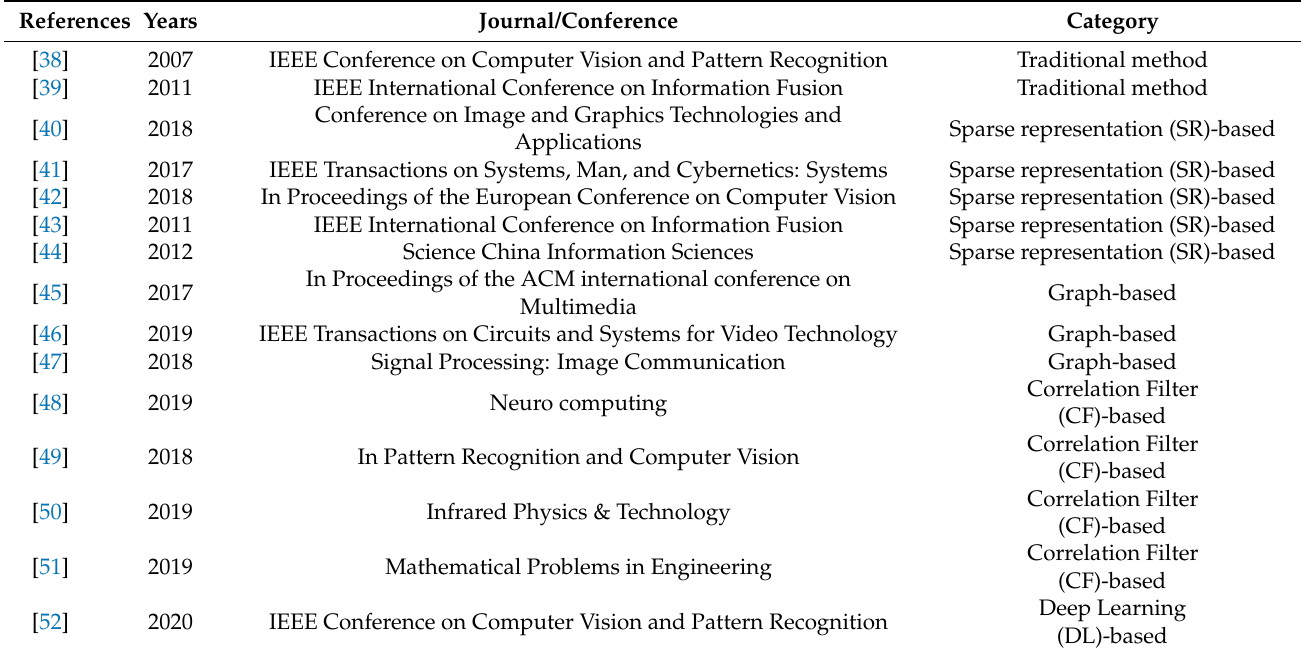
Table 2. Examples of recent published research on RGB-T